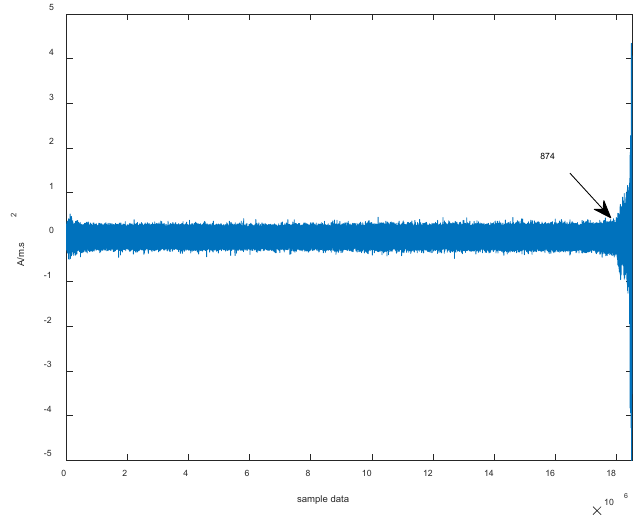
Figure 21. Life-time degradation time-domain waveform of bearing 3. The model proposed in this paper only uses the normal data of the rolling bearing to train the SVDD model. When the performance degradation of the rolling bearing needs to be verified, the failure or full-life cycle data of the rolling bearing can be used to obtain the performance degradation index curve. Therefore, this method cannot directly evaluate the degradation of rolling bearings that are not included in the learning process (the SVDD model is not trained with normal data). Similarly, since the normal thresholds corresponding to different bearings may vary greatly, and are prone to false alarms, the degradation threshold curve corresponding to the rolling bearing 1 cannot be directly used as the threshold curve of the rolling bearing 3. Therefore, the model still needs to be trained using the normal data of the bearing being evaluated. Bearing 3 degradation index based on LLE and SVDD is shown in Figure 22. Near the 108th sample point, the degradation index DI value exceeds the threshold line (green) of bearing 1, which is unreasonable, so the threshold line (red) trained by bearing 3 needs to be used. Similarly, at the 854th sample, the degradation index DI exceeds the threshold line. Compared with the time-domain waveform, the degradation index DI value not only clearly shows the degradation trend of bearing 3, but also earlier than the degradation point reflected by the time-domain